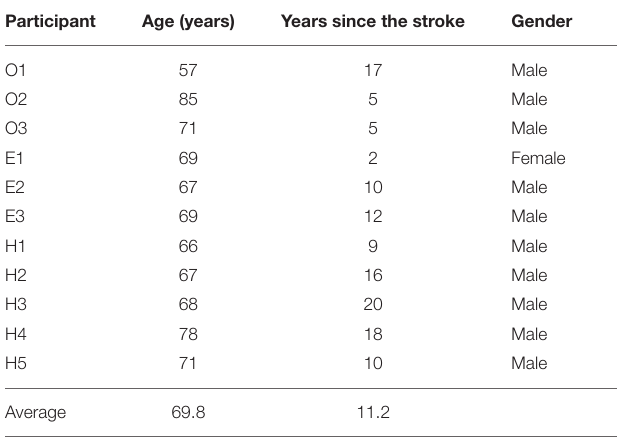
TABLE 2 | Participant demographics—Individuals with stroke ( N = 11).